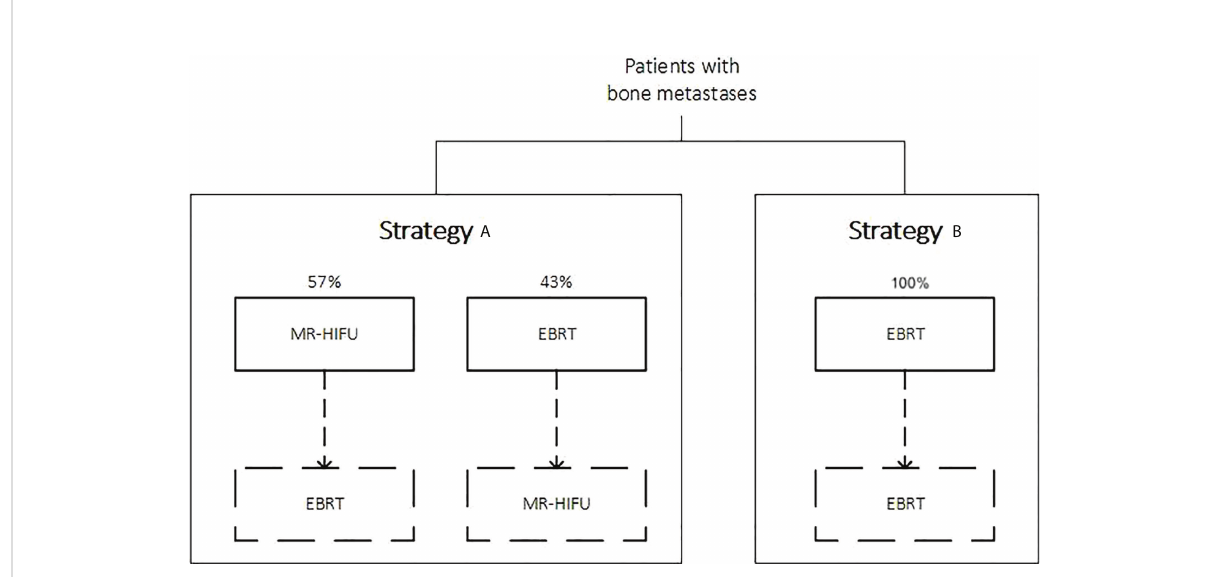
FIGURE 1 Strategies being compared. Dashed lines refer to the possibility of a retreatment in case of persistent pain or partial pain relief after a fi rst-line treatment (i.e., not all patients will undergo a retreatment in their lifetime, since some patients might die, or remain with unpalliated pain for some time before being recommended a